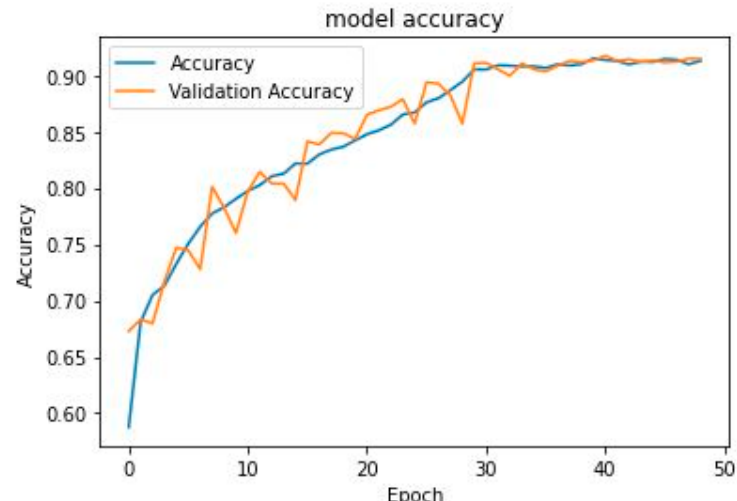
Figure 4. The learning curve for training and validation accuracy.